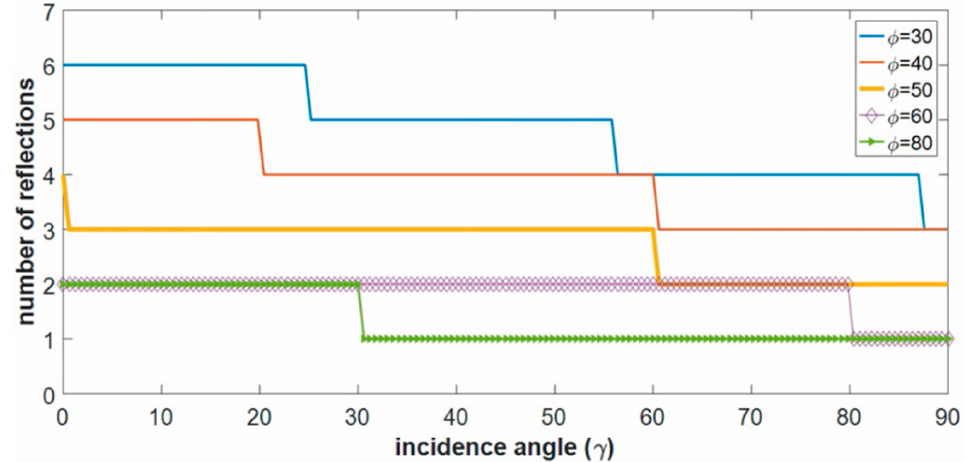
Figure 7. Total number of reflections occurring inside the cavity as a function of the angle of incidence for different opening angles.